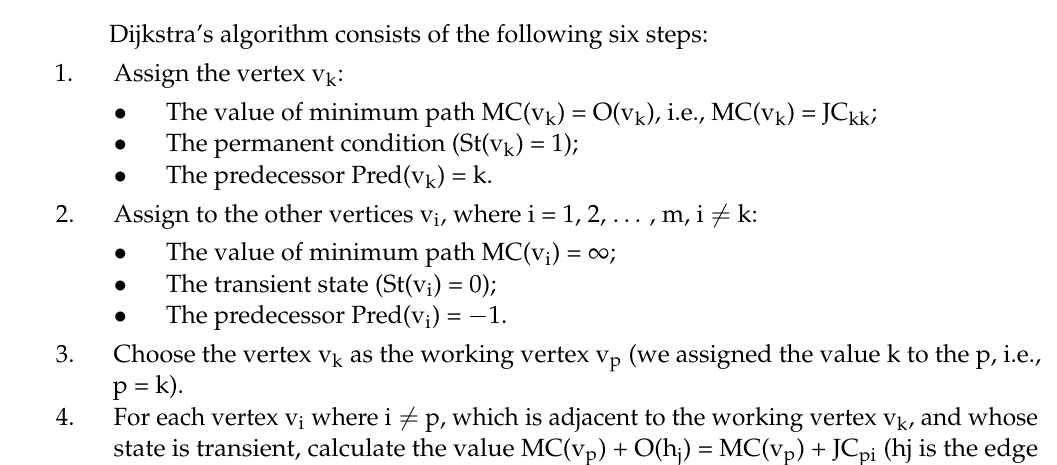
Figure 2. Dijkstra’s algorithm [Author own processing].